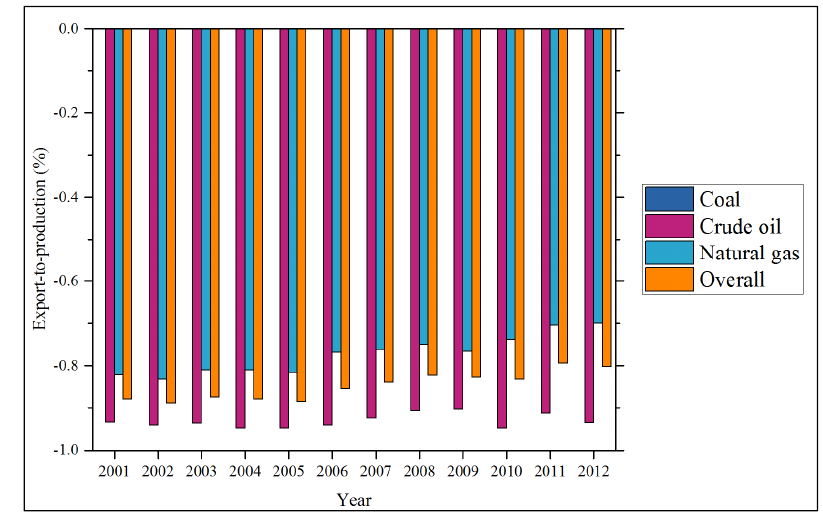
Figure 36. Brunei: export to production.